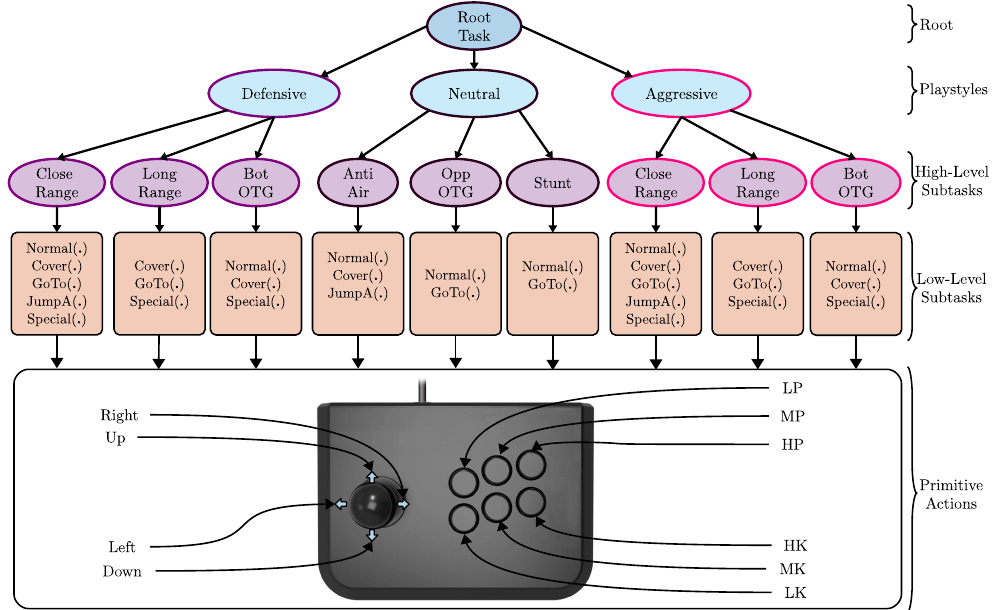
Figure 4. The task graph for our HRLB^2-based agent that plays Street Fighter IV